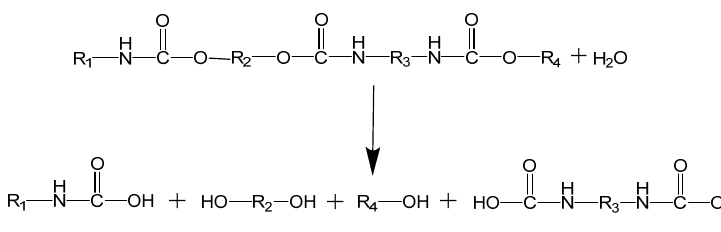
Scheme 5. Reaction scheme of the hydrolysis of PU.